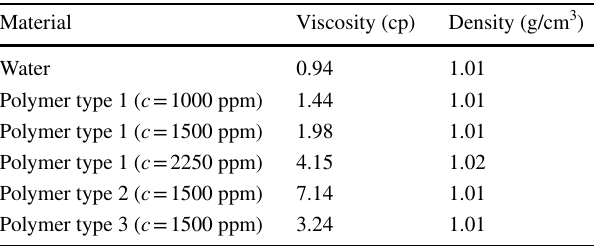
Table 2 Measured physical properties of water and polymer solutions at room temperature ( T = 24 °C) Material Viscosity (cp) Density (g/cm 3